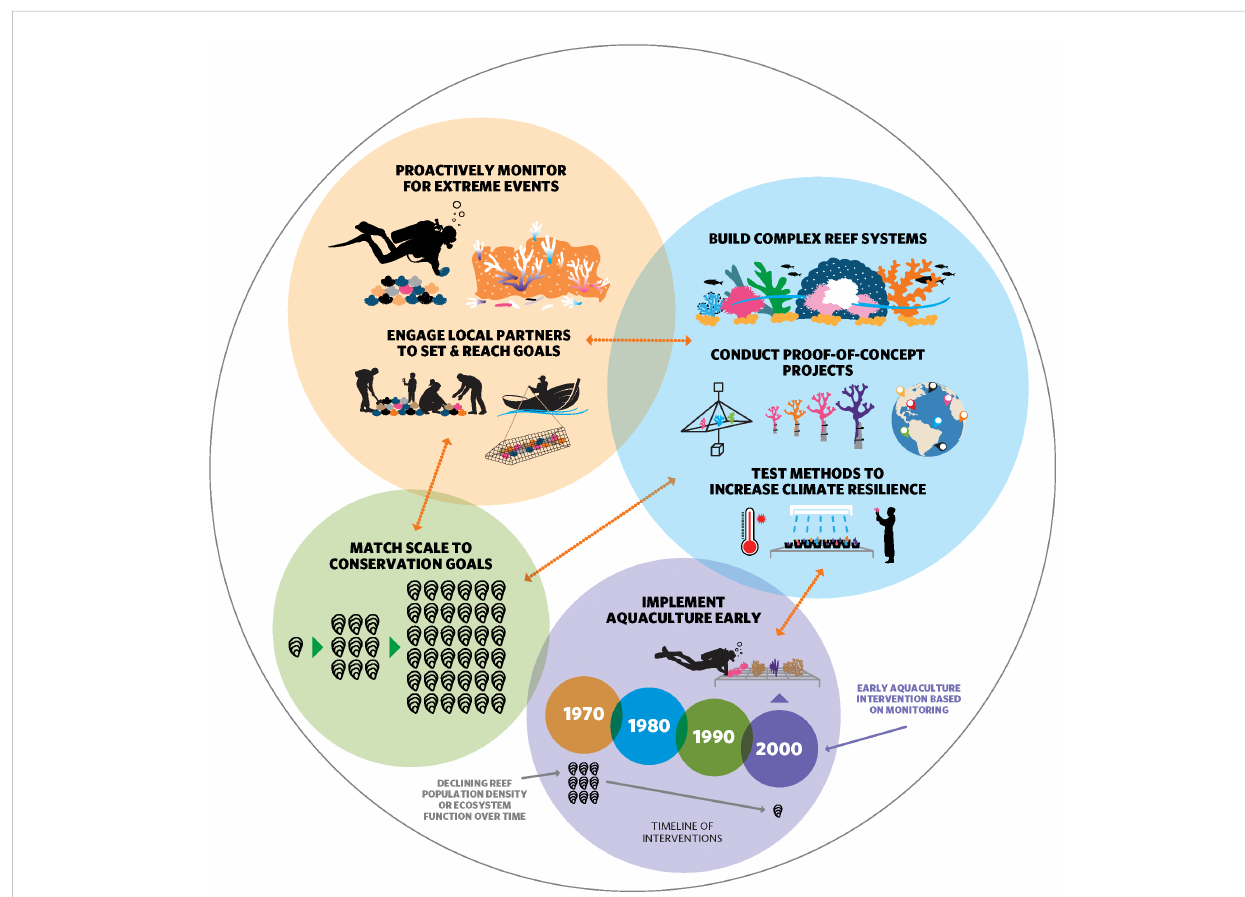
FIGURE 1 Iterative processes of development and implementation of reef conservation aquaculture. Ongoing and iterative activities (overlapping circles, orange arrows) must be started immediately to assess the need for and timing of aquaculture interventions, and to develop practical methods with suf fi cient lead time for implementation to be effective. Peach circle: Proactive, long term monitoring for extreme events and reef population declines (top: scuba diver monitoring an oyster bed, bleached and broken coral) and engagement of local partners, including Indigenous communities, to set and reach conservation goals (bottom: community oyster beds, fi sher) are critical foundations for aquaculture interventions. Blue circle: Research and development are needed to establish effective methods and technologies for building complex reef systems (top: restored coral reef) and testing promising methods to increase climate resilience on reefs (bottom: coral fragments are exposed to high temperatures to test differences in thermal tolerances). Proof-of-concept projects should be implemented on smaller scales across many reef systems (middle: different coral species are grown, outplanted on reefs in various locales). Green circle: The scale of aquaculture efforts should then be matched to conservation goals for reefs (oyster icons increase in number left to right to depict scaling up), using the data, goals, and methods that have been developed. Purple circle: The early implementation of aquaculture relative to population or ecosystem decline may therefore take decades to prepare for, making it urgent to begin these processes now (dated circles and oyster icons indicate that declines were detected in 1970s, but aquaculture only implemented at large scale 30 years